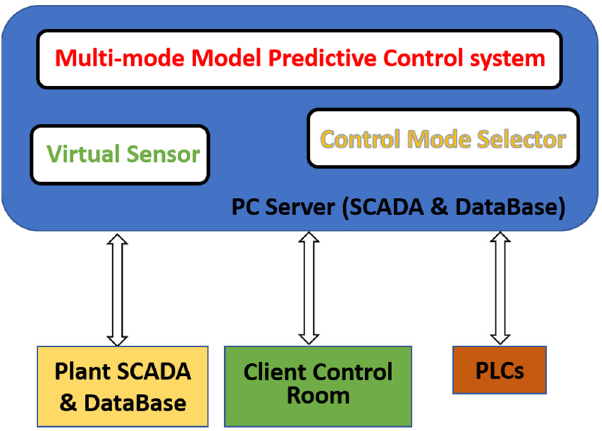
Figure 3. Architecture of the developed system.